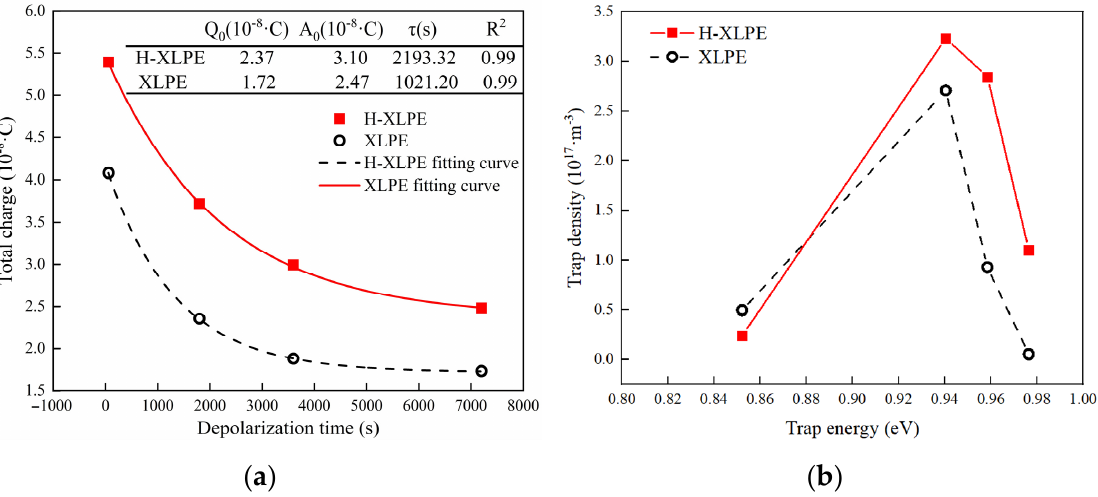
Figure 4. Trap characteristics: ( a ) the charge attenuation versus depolarization time; ( b ) trap density versus trap energy.